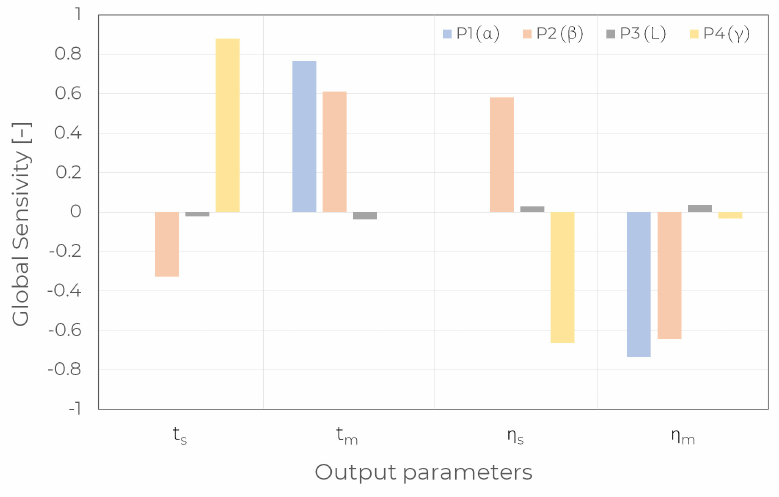
Figure 16. The GSA